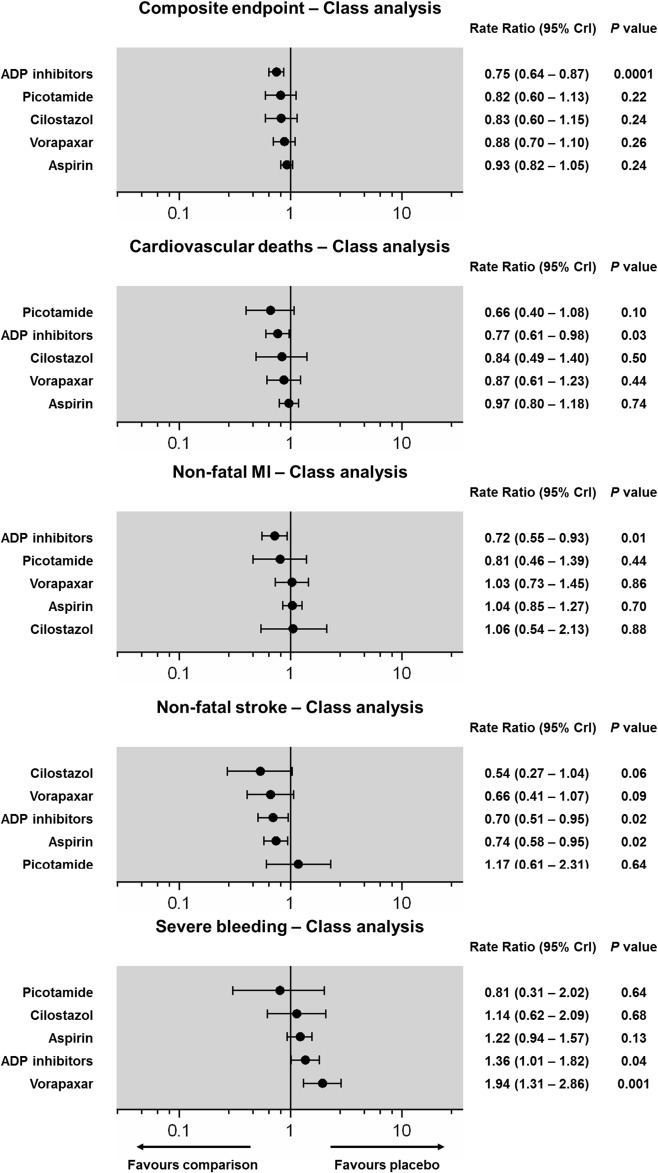
Class-level network fixed effects forest plots.Classes of antiplatelet agents are reported in order of efficacy or safety ranking. Black circles denote the posterior median and the black lines denote the associated 95% CrI. Numbers represent rate ratios (RR) and 95% CrIs. P values were approximated by the two-tailed posterior probabilities.